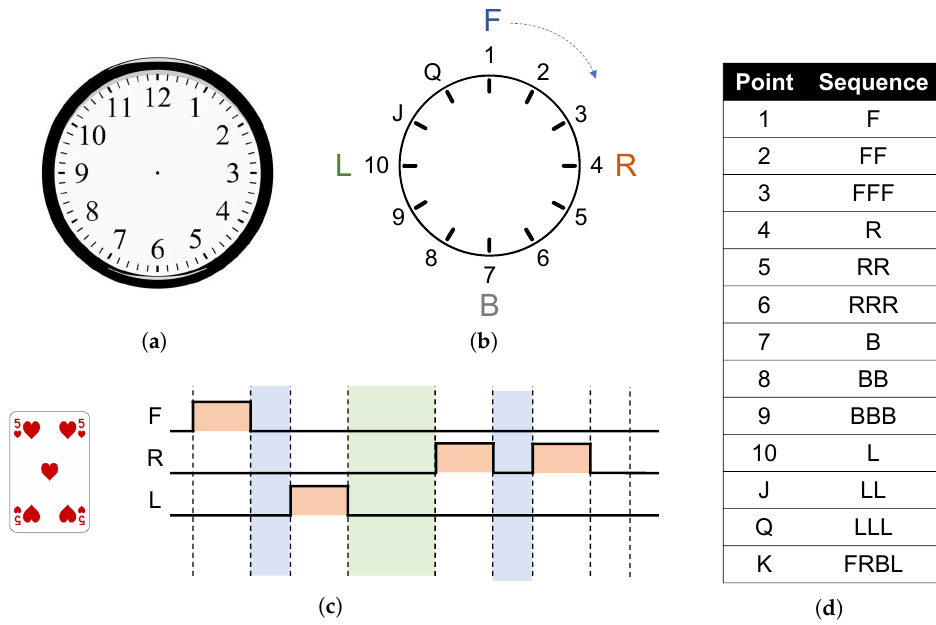
Figure 5. Poker stereoscopic digital coding, taking the 5 of spades coding as an example. ( a ) A dial. ( b ) The three-dimensional distribution of the motor in the neck corresponds to the dial and the number. ( c ) Motor timing diagram corresponding to the 5 of spades code. ( d ) The poker number code corresponding to the neck